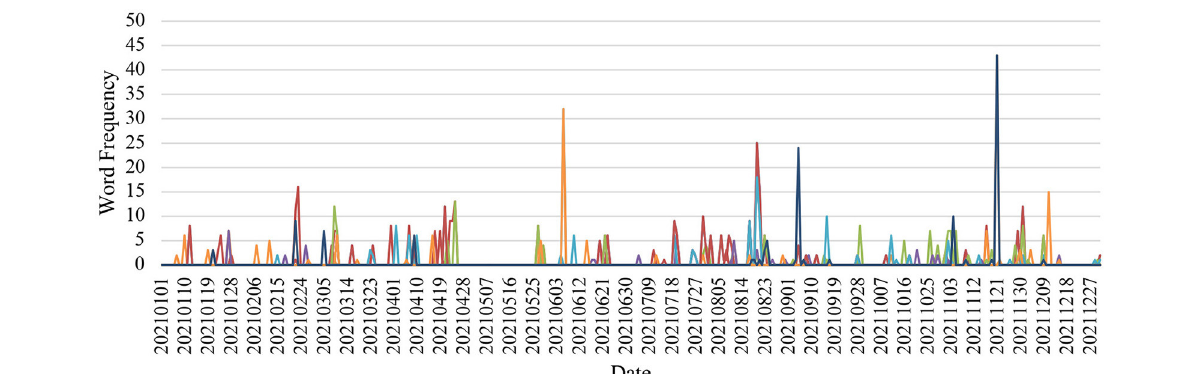
FIGURE5 E Fund Blue Chip Select Mix Fund.